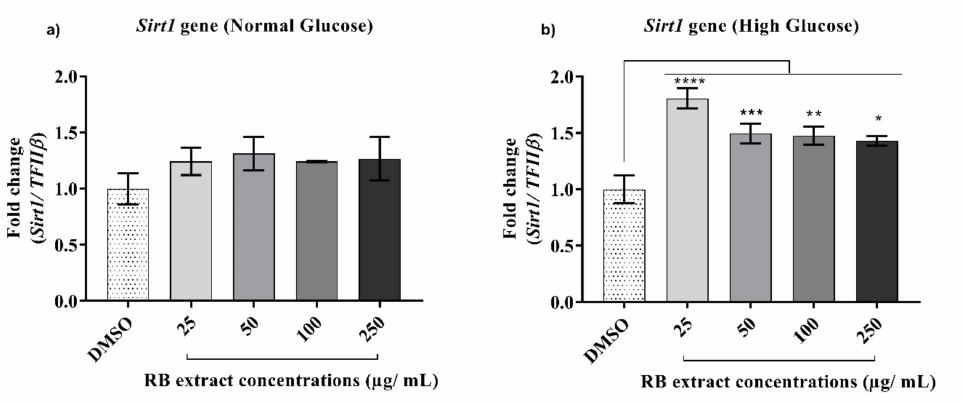
Figure 4. E ff ect of RB phenolic extracts on the expression of the Sirt1 gene under normal and high glucose conditions in INS-1E cells. ( a ) Normal glucose conditions, ( b ) High glucose conditions ( n = 5). The level of significance is indicated by the asterisks, whereby * p < 0.05, ** p < 0.01, *** p < 0.001, **** p < 0.0001. Data are presented as Mean ± SD. Dimethyl sulfoxide, DMSO; Insulin-secreting rat insulinoma cell, INS-1E; Rice bran, RB; Sirtuin 1, Sirt1 .